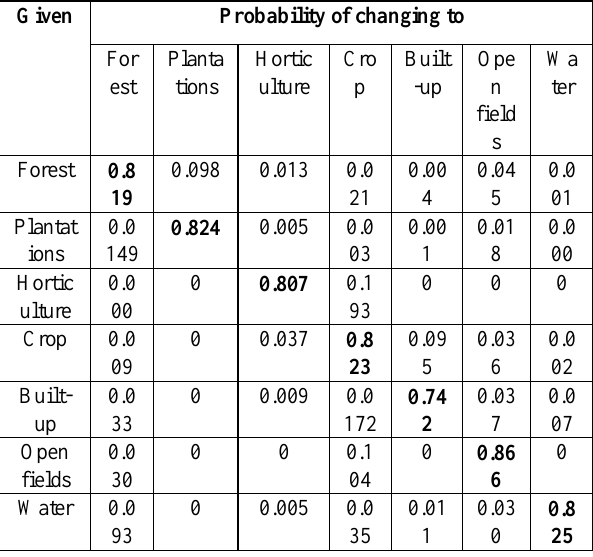
Table 4(a). Transition probability matrix for 2007-2010. Given